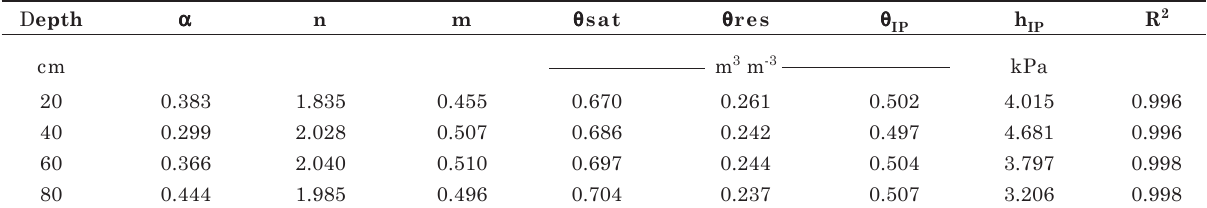
Table 3. Parameters of the van Genuchten equation (m, n, ααααα ), moisture at saturation ( θθθθθ sat), residual moisture ( θθθθθ res), moisture at inflection points ( θθθθθ IP ), tension at the inflection point (h IP ) and coefficient of determination of the model adjusted to a Red Latossol at depths of 20, 40, 60, and 80 cm